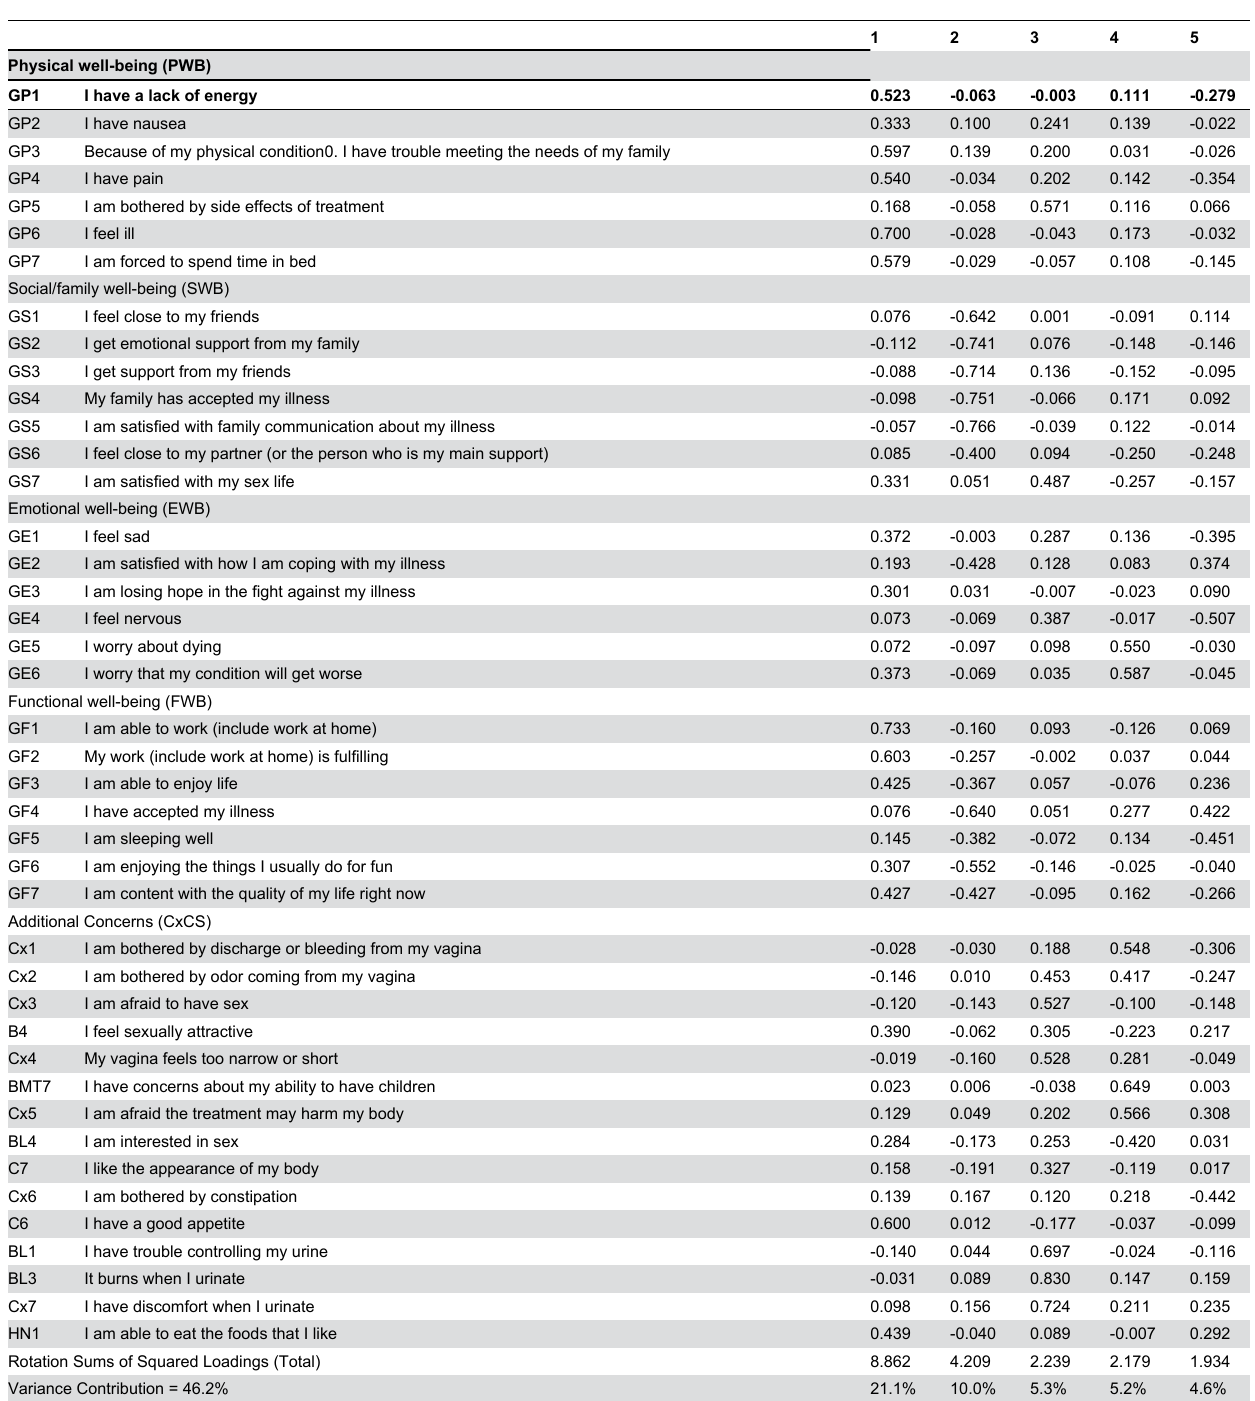
Table 4. Factor Analysis of FACT-CX